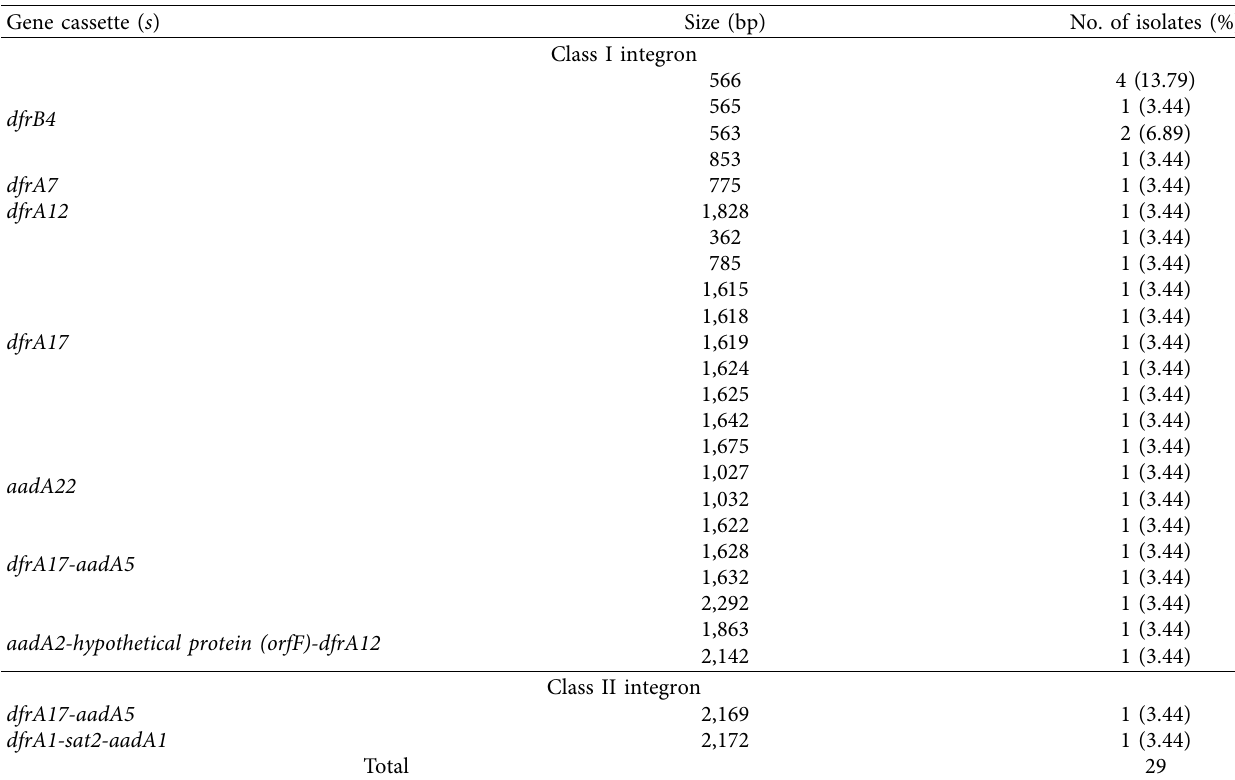
Table 4: Size and number of gene cassettes amplified from integron-positive E. coli isolates’ variable